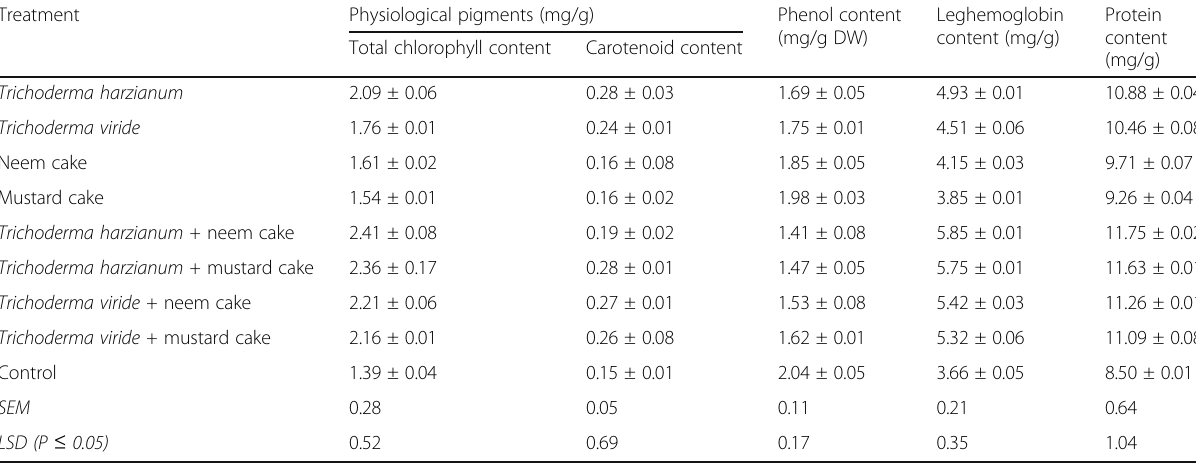
Table 3 Effect of the application of the tested bioagents and organic amendments on the physiological parameters of mungbean grown in soil infested with Rhizoctonia bataticola